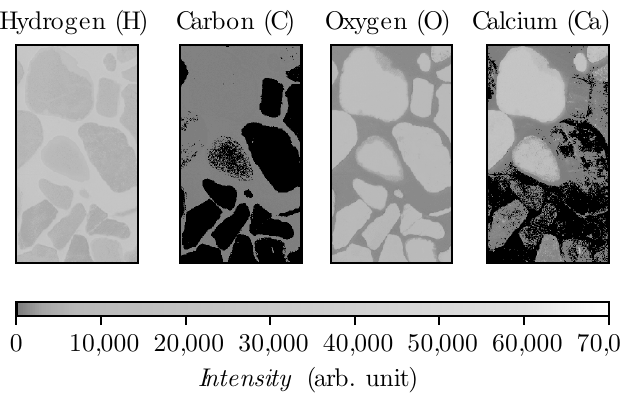
Figure 3. Heatmap from epoxy specimen in spectral range 525–940